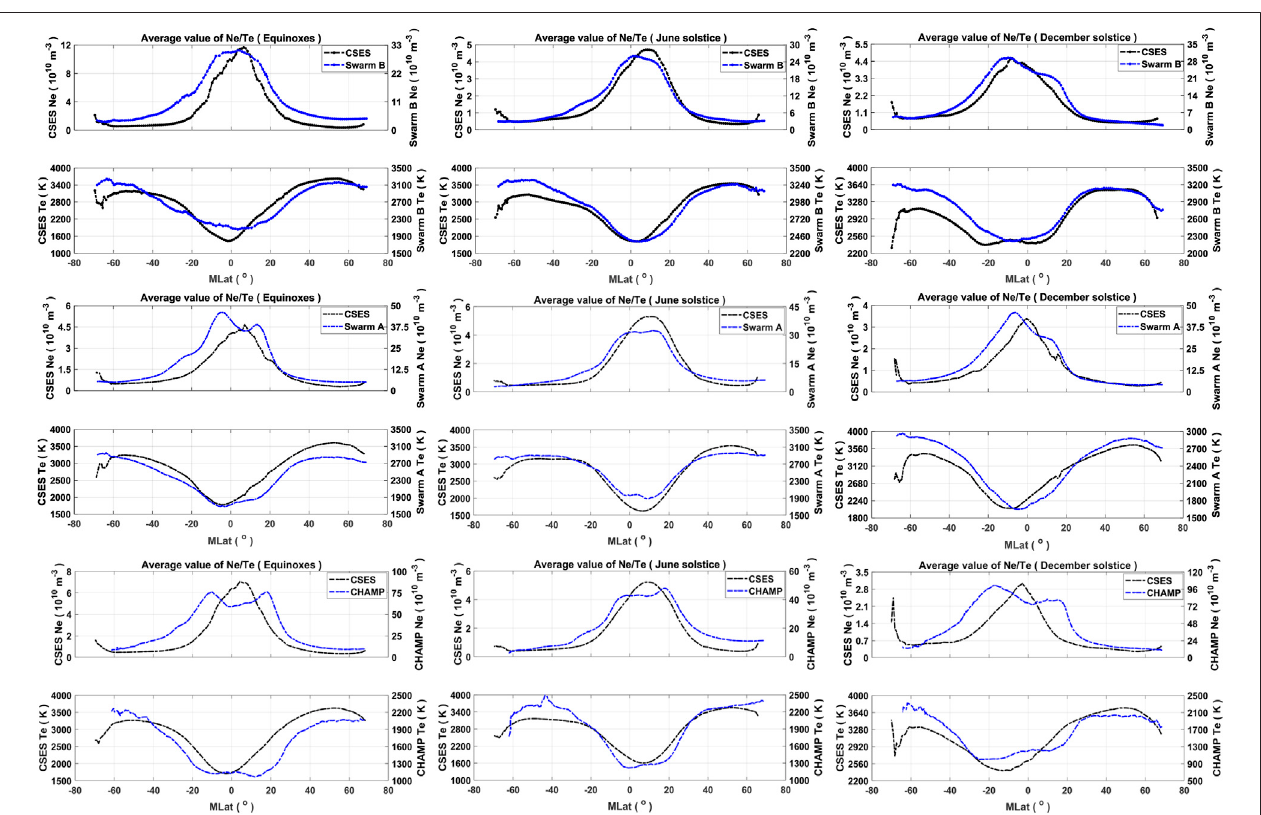
FIGURE3 | The averagepro fi les comparison of Ne/Te between CSES & Swarm B, CSES and Swarm A and CSES and CHAMP. Theaveragepro fi les of CSES are shown as black lines, while the pro fi les from the other three satellites are shown as blue lines.